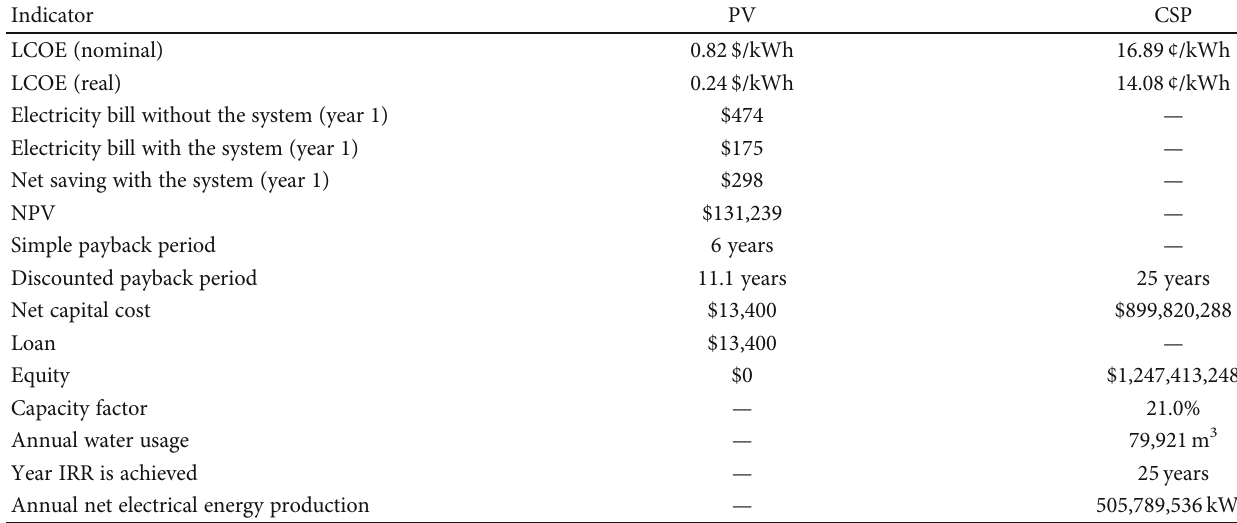
Table 11: Economic evaluation between PV and CSP